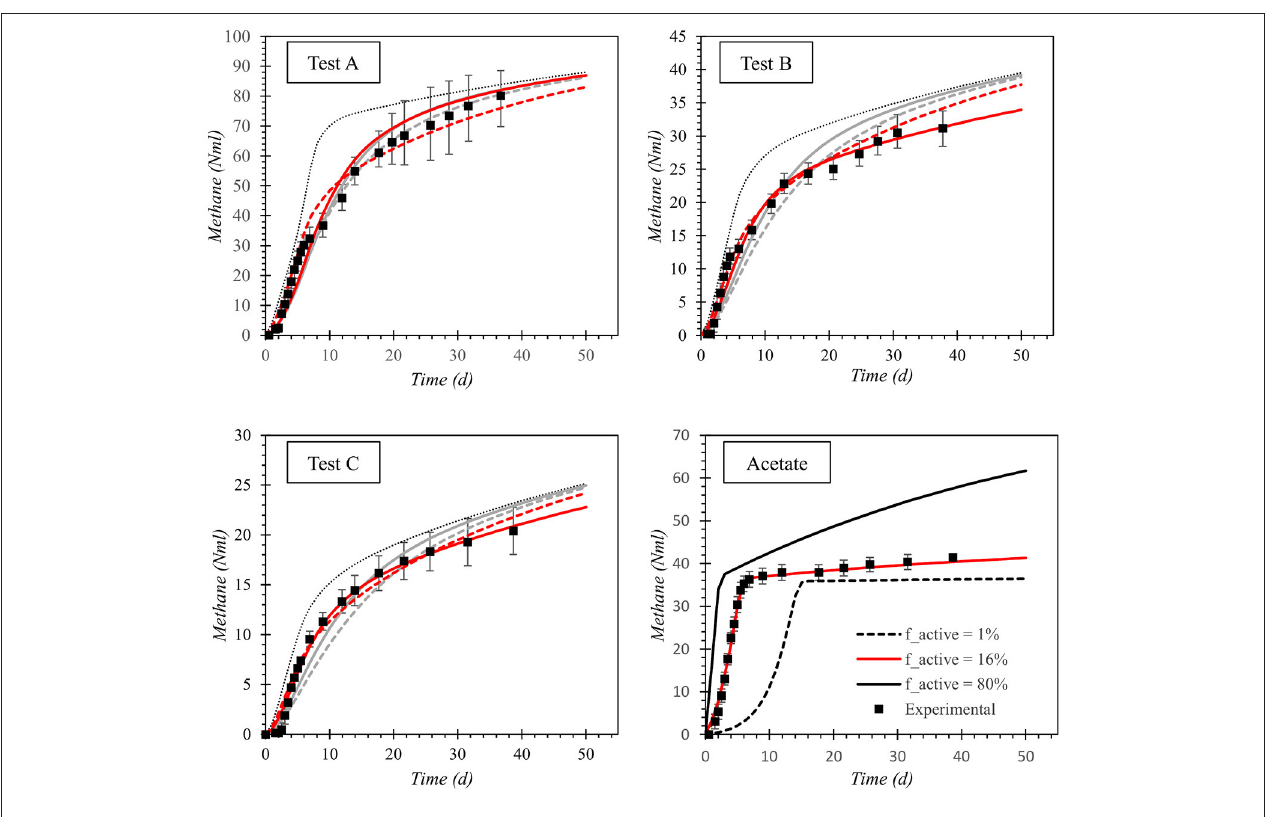
FIGURE 3 | Simulation results for Experiment 2, with Tannery Fleshing ( Default ADM1; 1st order disintegration; Contois disintegration; Rapid/Slow_1st order Disintegration; Rapid/Slow_Contois Disintegration; Experimental).